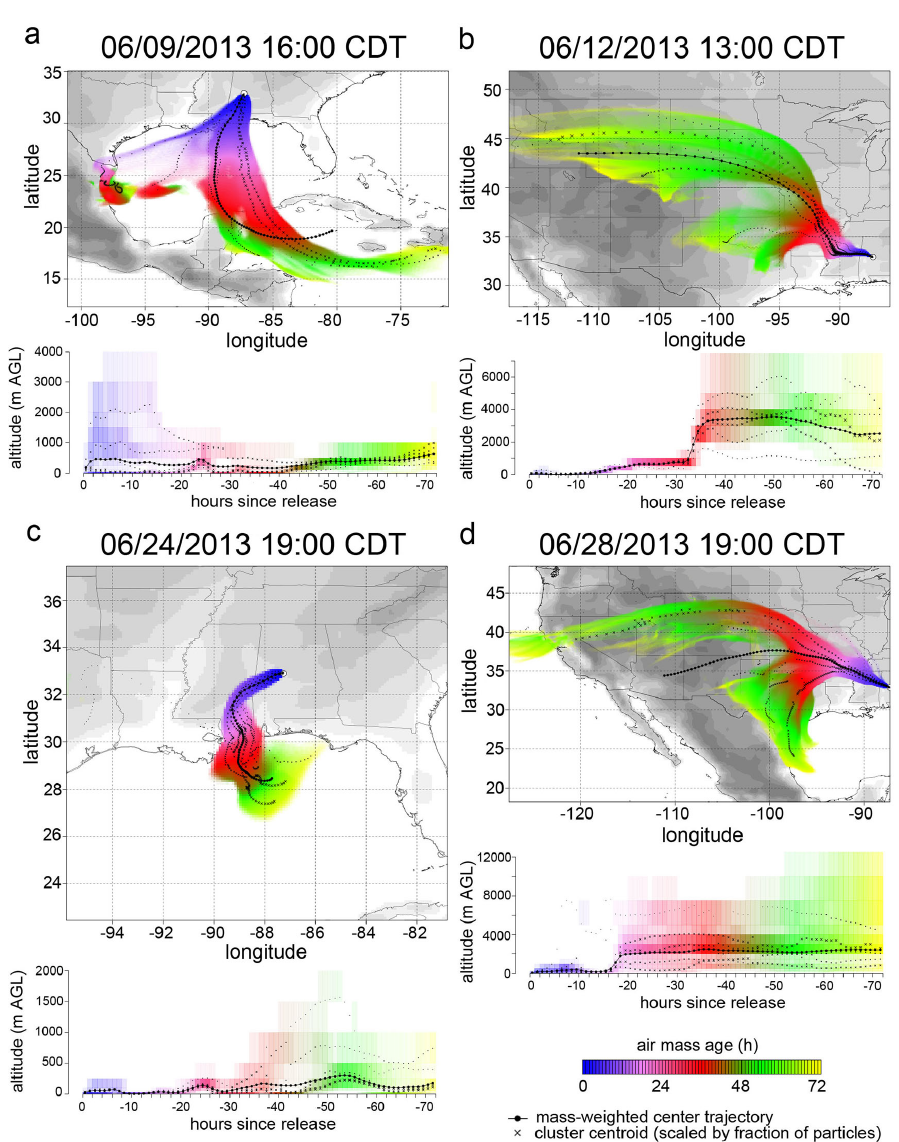
Figure 4. Shown are 3-day back trajectories at the Centreville site (circled), displaying horizontally integrated (top) and vertically integrated (bottom) trajectories with mass-weighted and cluster centroid trajectories as defined by Stohl et al. (2002), for (a) event 1 on 9 June, (b) event 1 on 12 June, (c) event 2 on 24 June, and (d) event 2 on 28 June. Times shown correlate with peaks indicated by vertical bars in Fig.